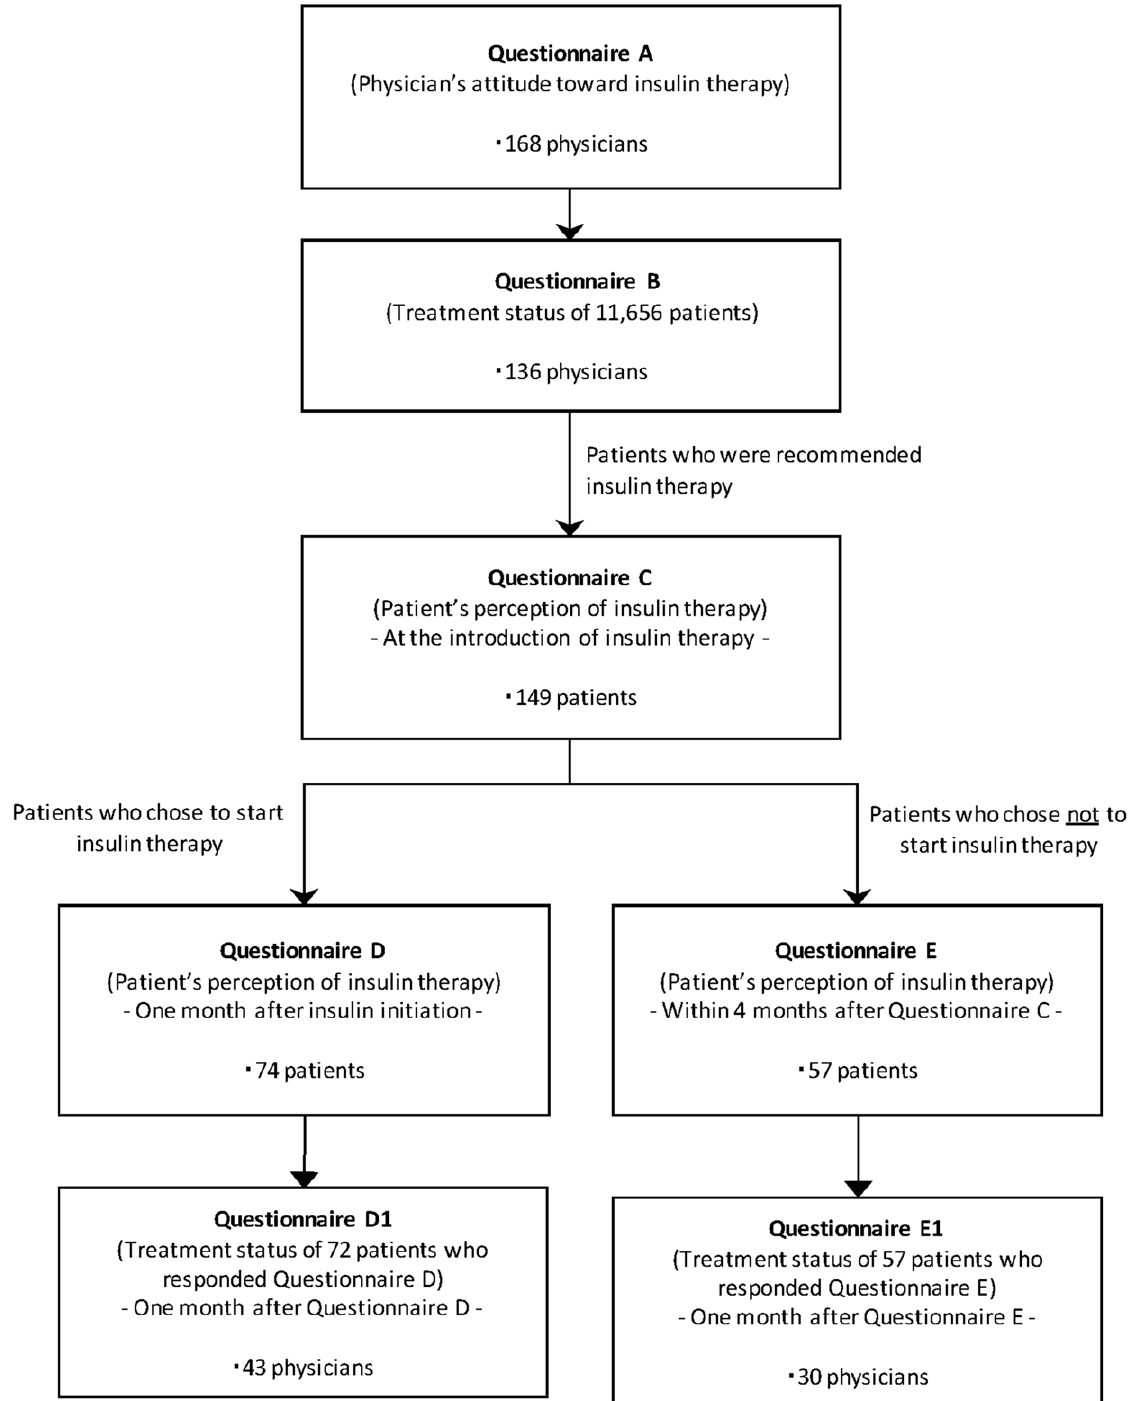
Figure 1. The survey process of DAWN JAPAN study.